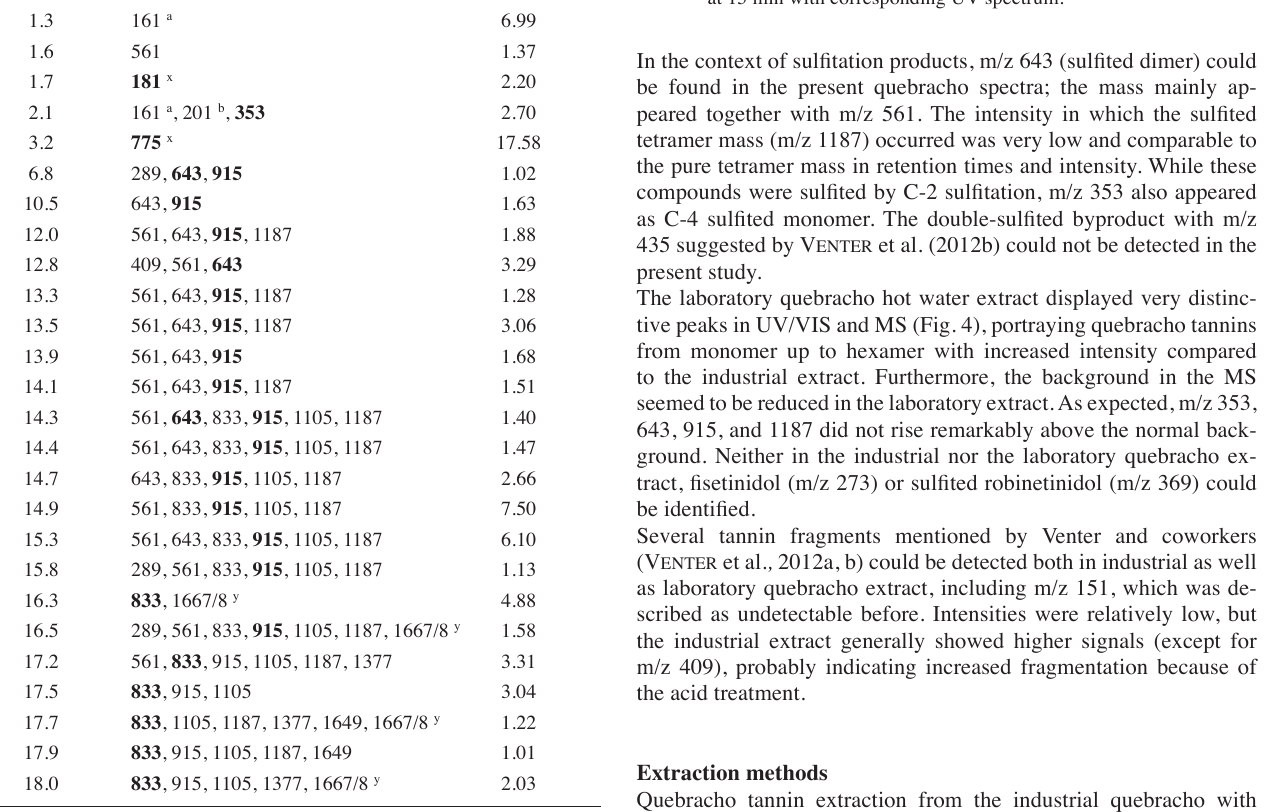
Fig. 3: MS spectrum of industrial quebracho extract (hot water extraction) at 15 min with corresponding UV